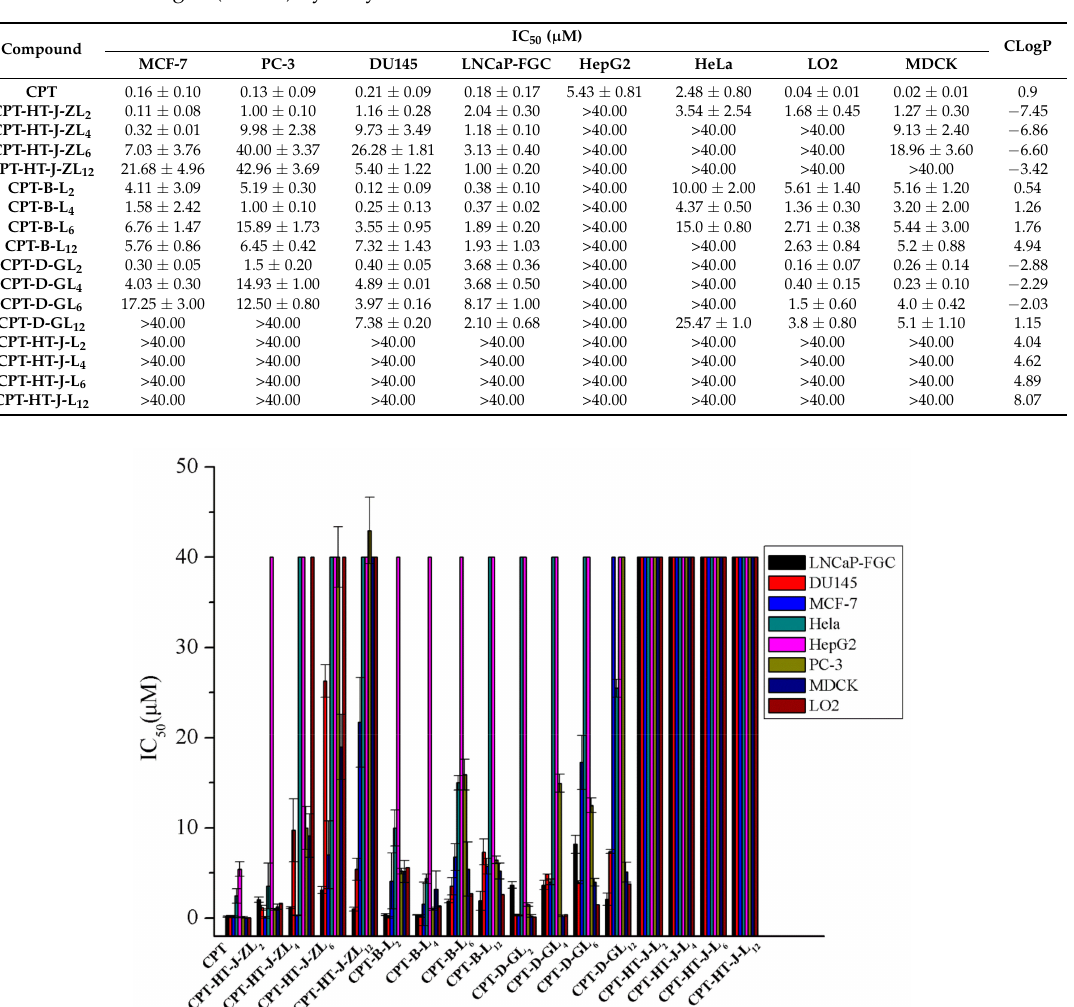
Table 1. The anti-proliferative effects and ClogP values of the CPT-HT-J-ZLn and the prostate-specific membrane antigen (PSMA) hydrolysate CPT-D-GLn .